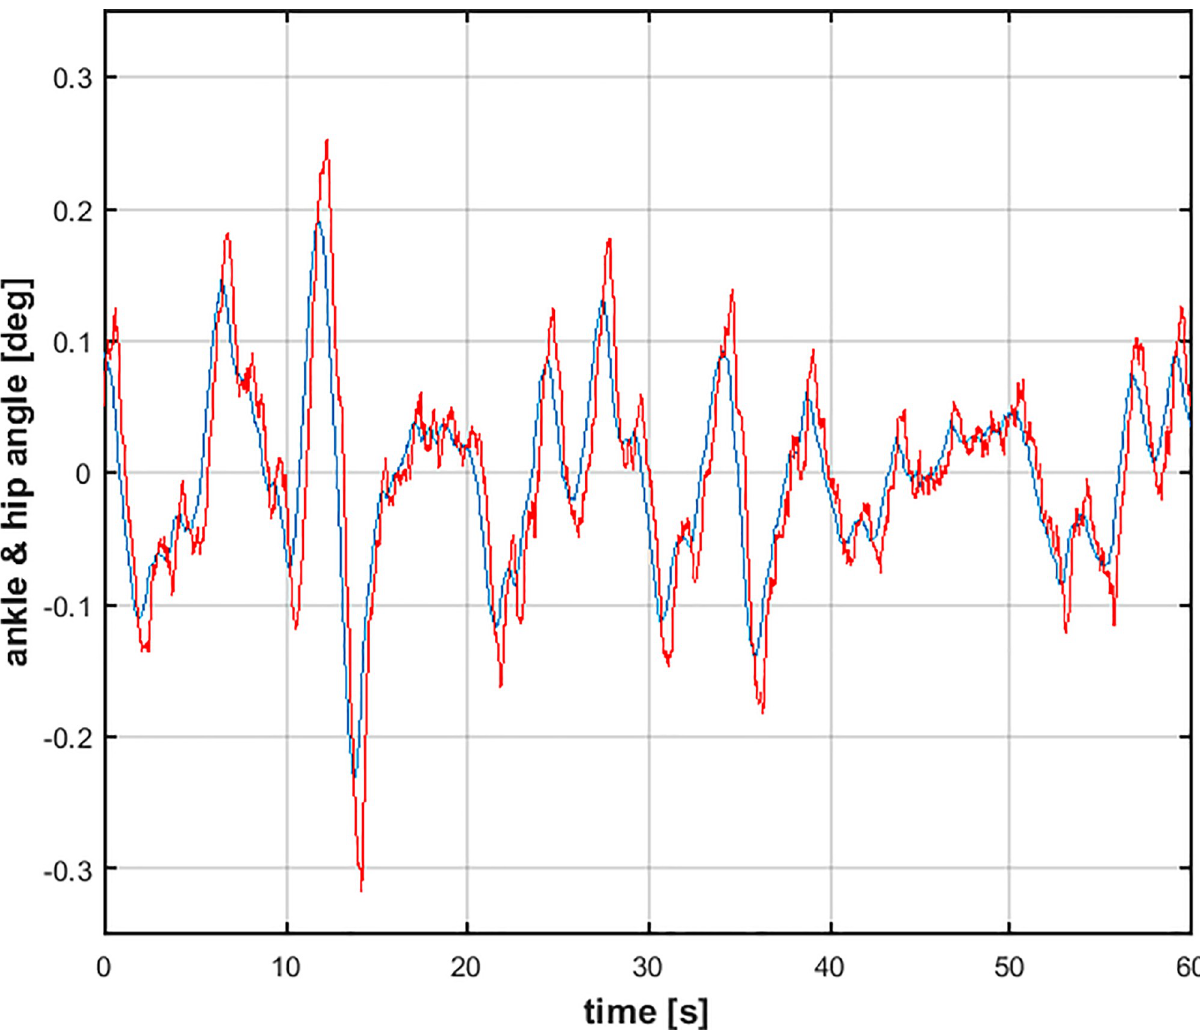
Fig 3. Sway movements generated by the simulation of the DIP/VIP hybrid model. Blue trace: ankle joint rotation; Red trace: hip joint rotation.